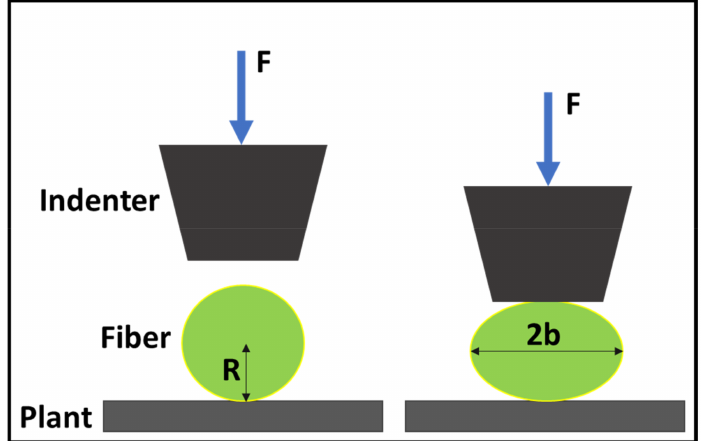
Figure 5. Schematic diagram of the transverse